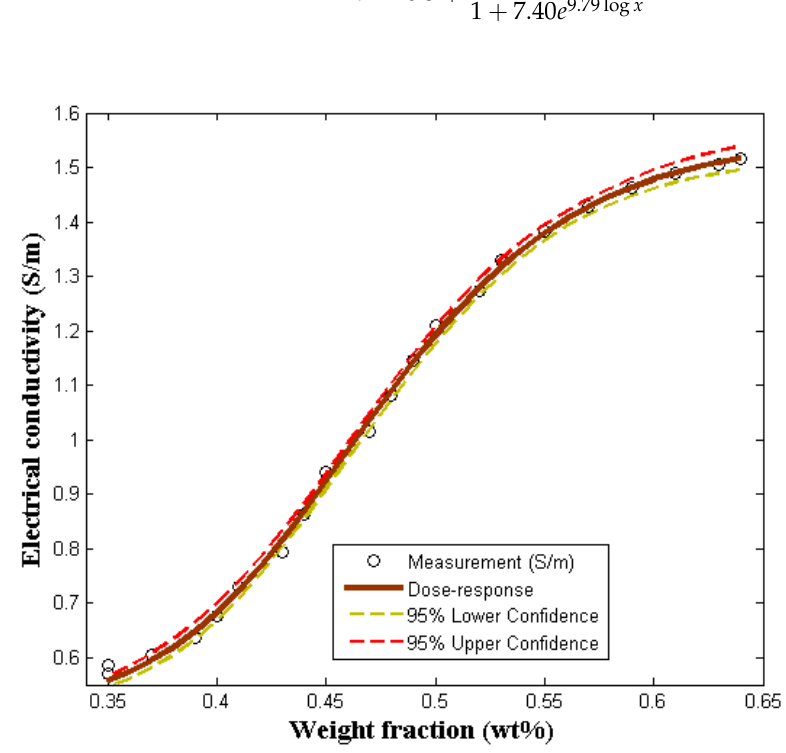
Figure 5. Comparing the dose–response model with experimental measurement. Table 3. Dose–response performance